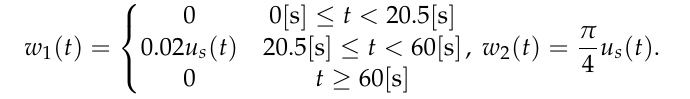
Figure 10. Heading angle of the vehicle. 5. Discussion In its general form, the problem of common noninteracting control with simultane- ous common partial output zeroing is applicable in the sense that some of the outputs are independently controlled while some of them are retained at their nominal values. Such a requirement can be met in redundant manipulators, multi-mode processes, and robotic vehicles.